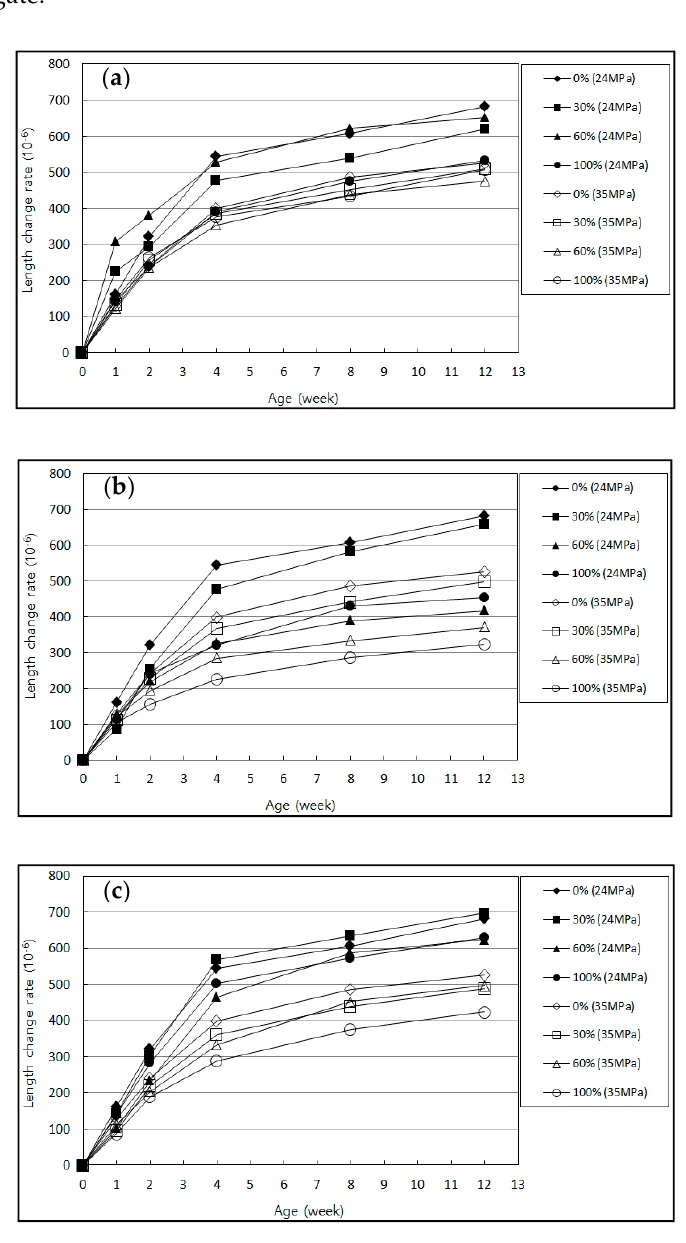
Figure 14. Length change rate according to age: ( a ) Recycled coarse aggregate replacement, ( b ) recycled fine aggregate before modification, and ( c ) recycled fine aggregate after modification.